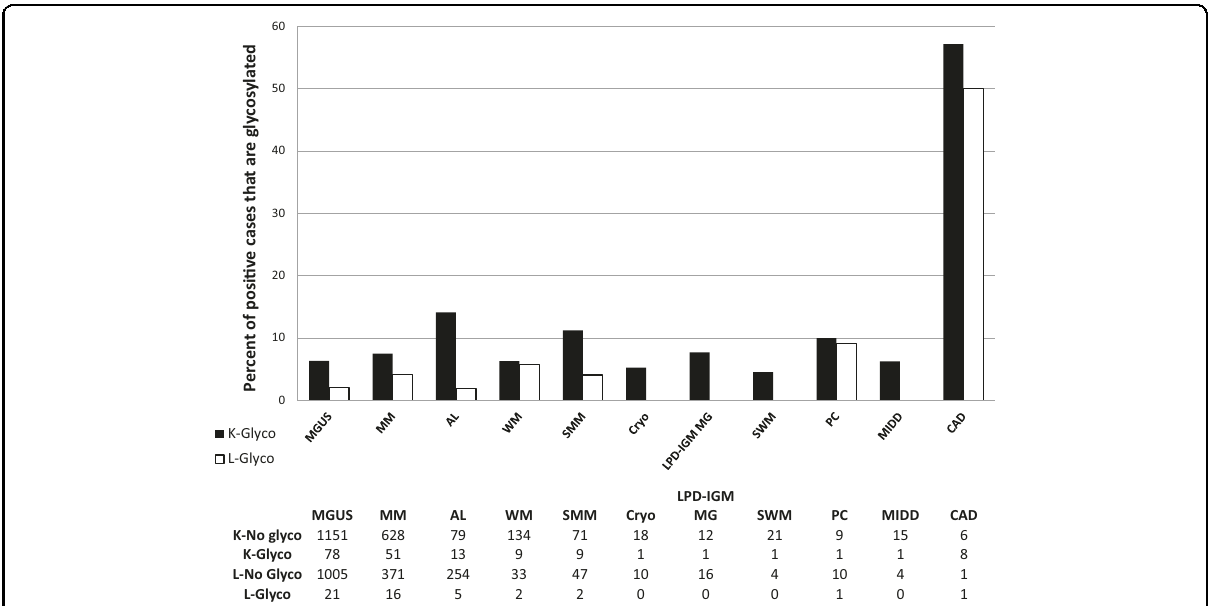
Fig. 4 Glycosylation status by diagnosis and light chain restriction. MGUS monoclonal gammopathy of undetermined signi fi cance, MM multiple myeloma, AL immunoglobulin light chain amyloidosis, WM Waldenstrom ’ s macroglobulinemia, SMM smoldering multiple myeloma, Cryo cryoglobulinemia, LPD-IGM MG lymphoproliferative disorder with monoclonal gammopathy, SWM smoldering Waldenstrom ’ s macroglobulinemia, PC plasmacytoma, MIDD monoclonal immunoglobulin deposition disease, and CAD cold agglutinin disease. Note that non-glycosylated kappa and lambda light chains (LC) are not mutually exclusive due to bi and triclonality. However, glycosylated LC are mutually exclusive, as LC isotype is in reference to the glycosylated LC, and no patients had glycosylated LC of different